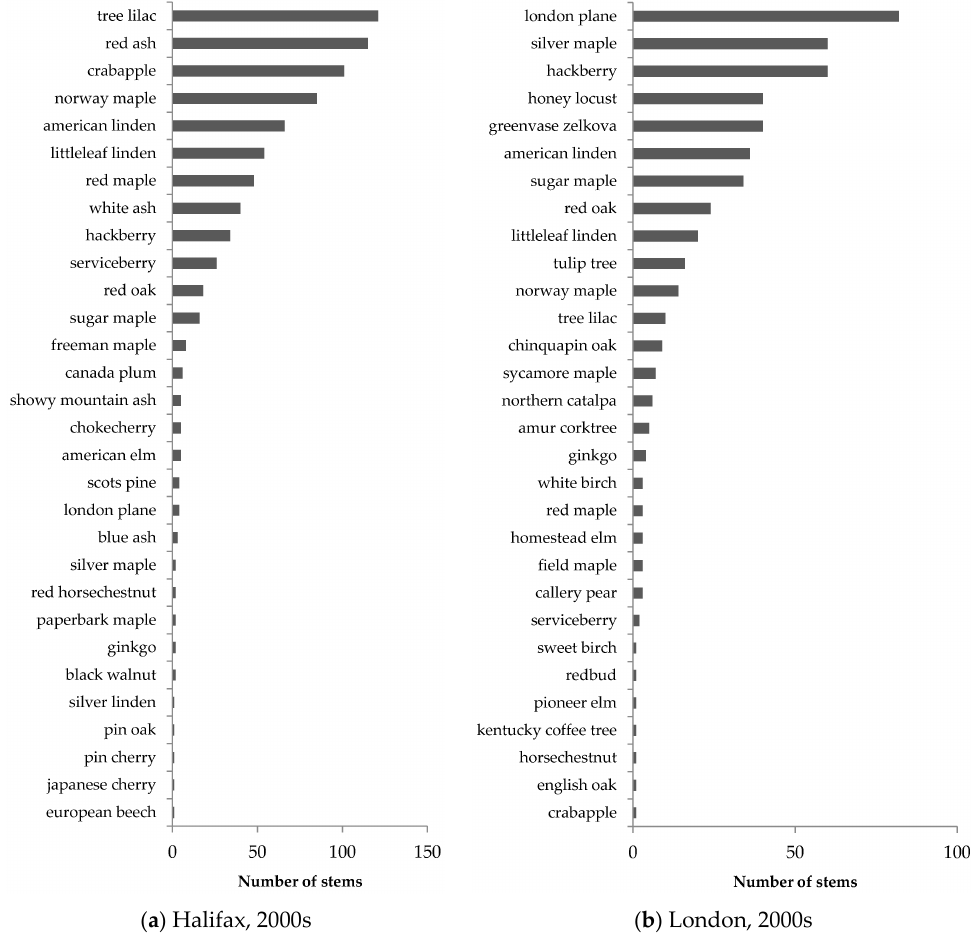
Figure 6. Combined relative species abundance of street trees in neighbourhoods developed <15 years ago: ( a ) Relative species abundance of street trees in two neighbourhoods in Halifax; ( b ) Relative species abundance of street trees in two neighbourhoods in London.